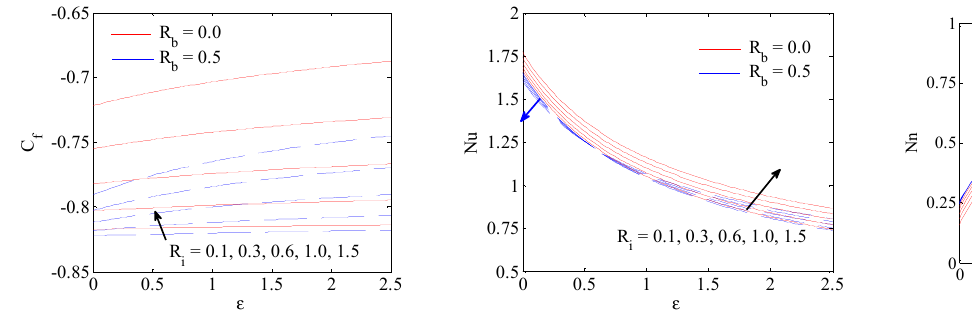
Figure 3. Fluctuations of C f , Nu and Nn due to R i factor.